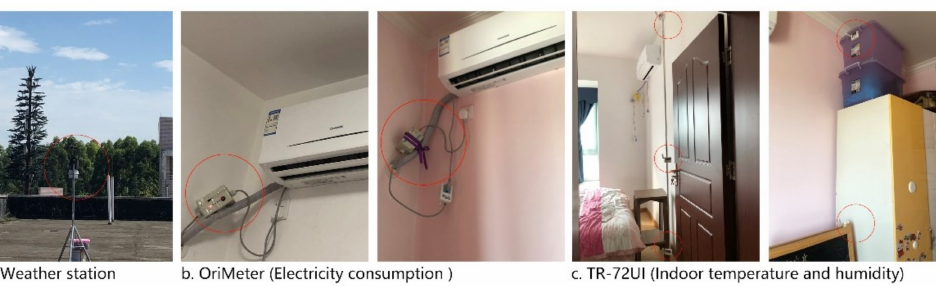
Figure 10. Actual view of the installed